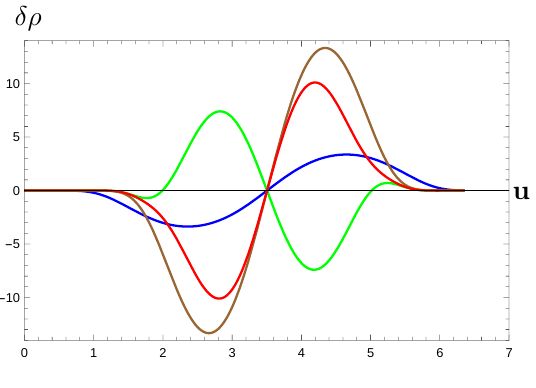
Figure 15. Plot of (cid:14)(cid:18) for h = 326 for four di(cid:11)erent number of terms i) N = 5 (blue), ii) N = 21 (brown), iii) N = 33 (green) & iv) N = 43